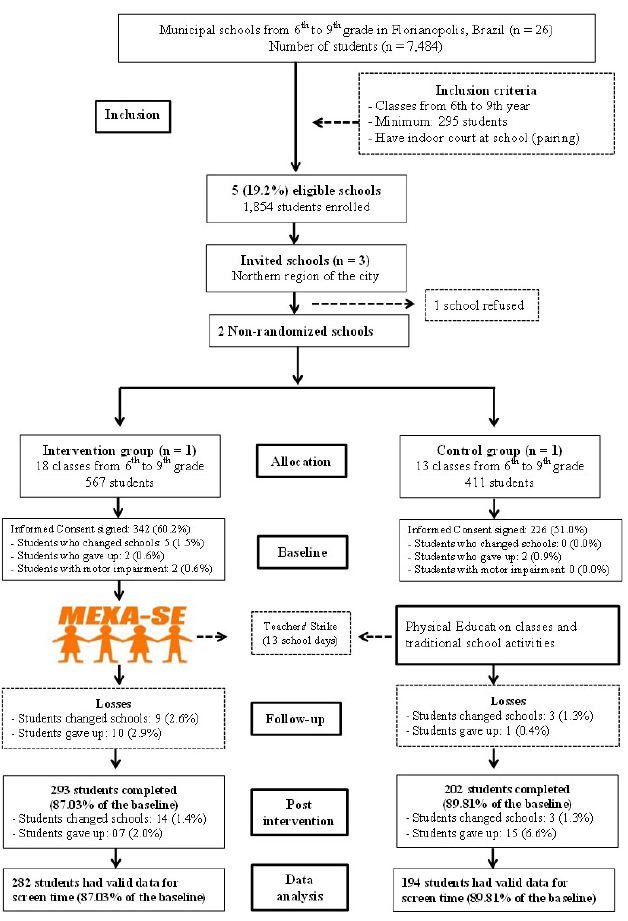
Figure 1. Flow diagram of the MEXA-SE study for the screen time